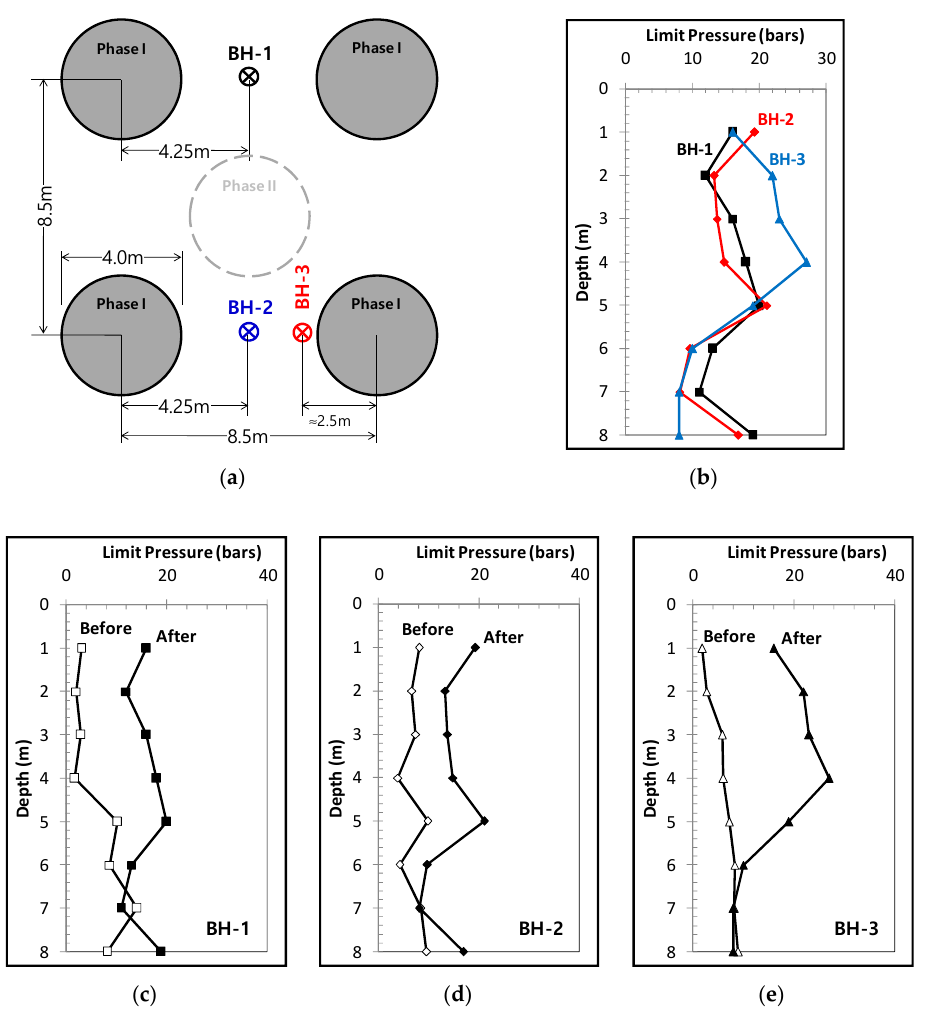
Figure 15. Comparison of pressuremeter test results before and after dynamic compaction: ( a ) tamping grid; ( b ) limit pressure after applying dynamic compaction; ( c ) limit pressure measurements in BH-1; ( d ) limit pressure measurements in BH-2; ( e ) limit pressure measurements in BH-3. The increase in strength due to dynamic compaction was larger at BH-3 than BH-1 or BH-2. It